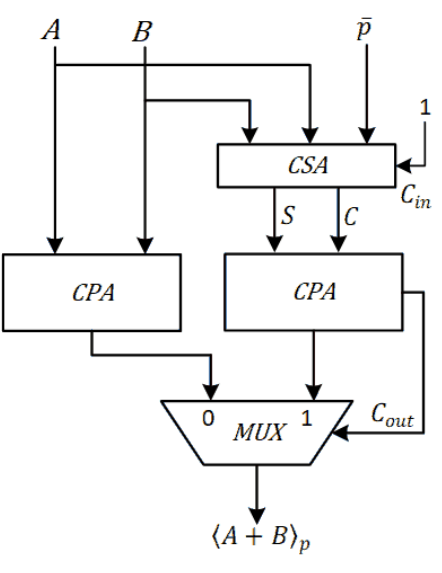
Figure 7. Hardware implementation of modular addition ( A + B mod p